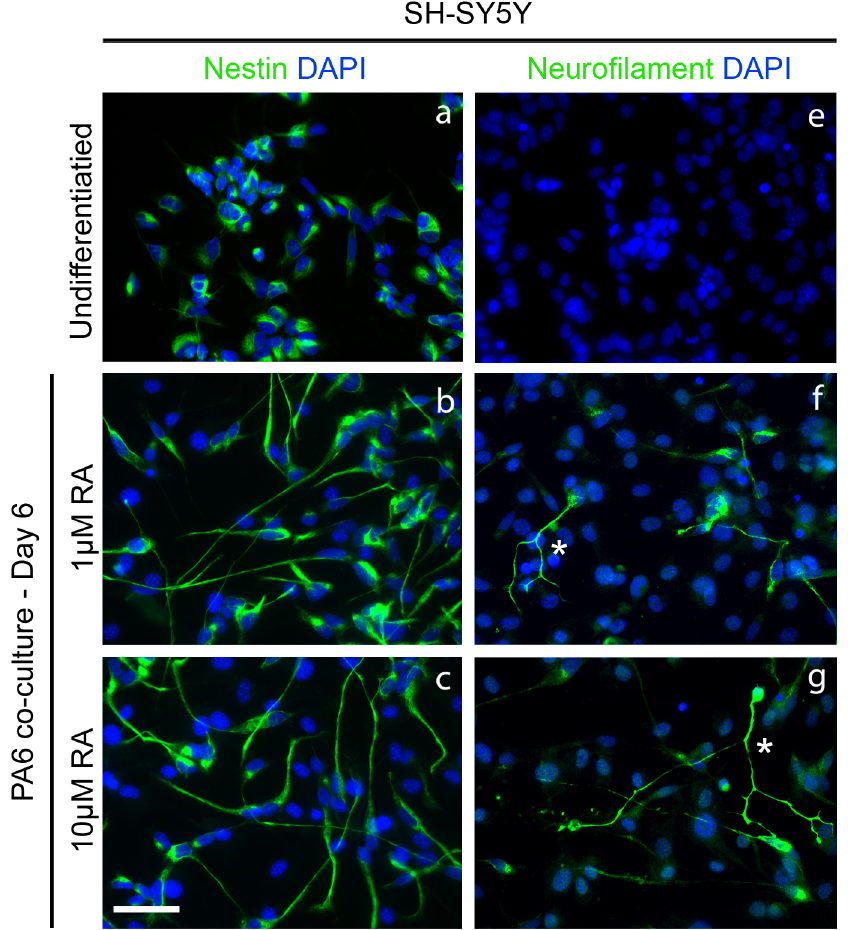
Fig 2. Comparison of differing RA concentrations on SH-SY5Y differentiating on PA6. Undifferentiated SY5Y express nestin but not neurofilament (a, e). Differentiation on PA6 with 1 μ M or 10 μ M RA results in the extension of nestin positive processes by day six (b, c). A proportion of these extended neurites are neurofilament positive. More neurites are neurofilament positive at 10 μ M RA (g) compared to 1 μ M (f). Scale bar 50 μ